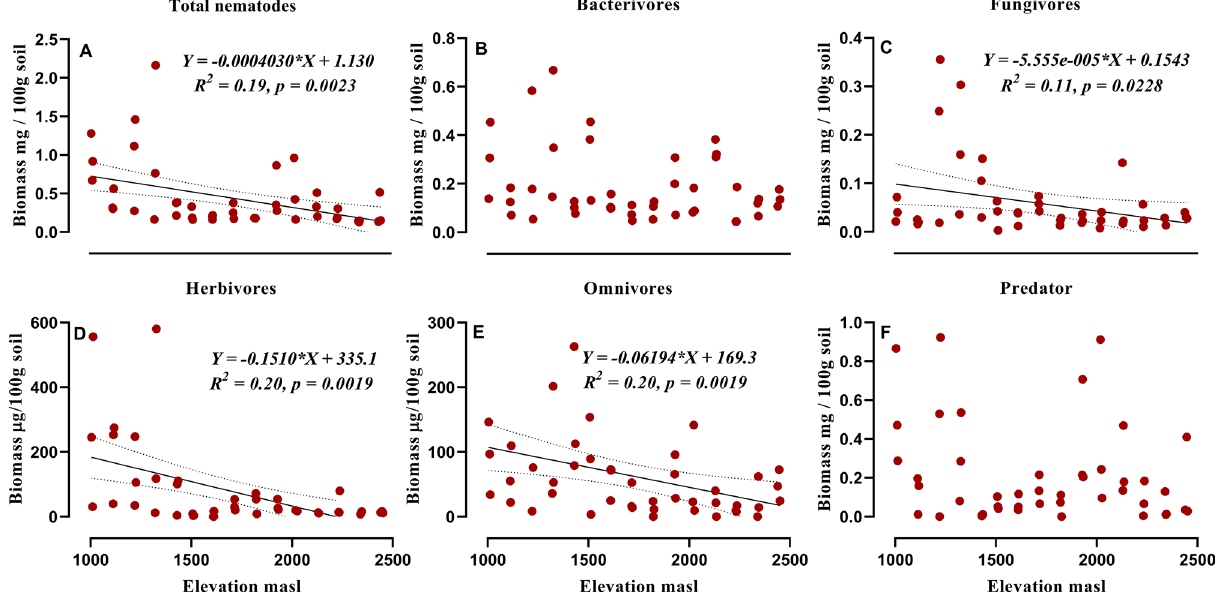
Figure 3. Relationship between elevation and total biomass of nematodes ( A ), biomass of trophic groups: Bacterivores ( B ), Fungivores ( C ), Herbivores ( D ), Omnivores ( E ), Predators ( F ). Equation for Y , R 2 (coefficient of determination), p (significance) of linear regression, regression line and dotted lines of 95% of confidence interval are displayed only for significant relationships.